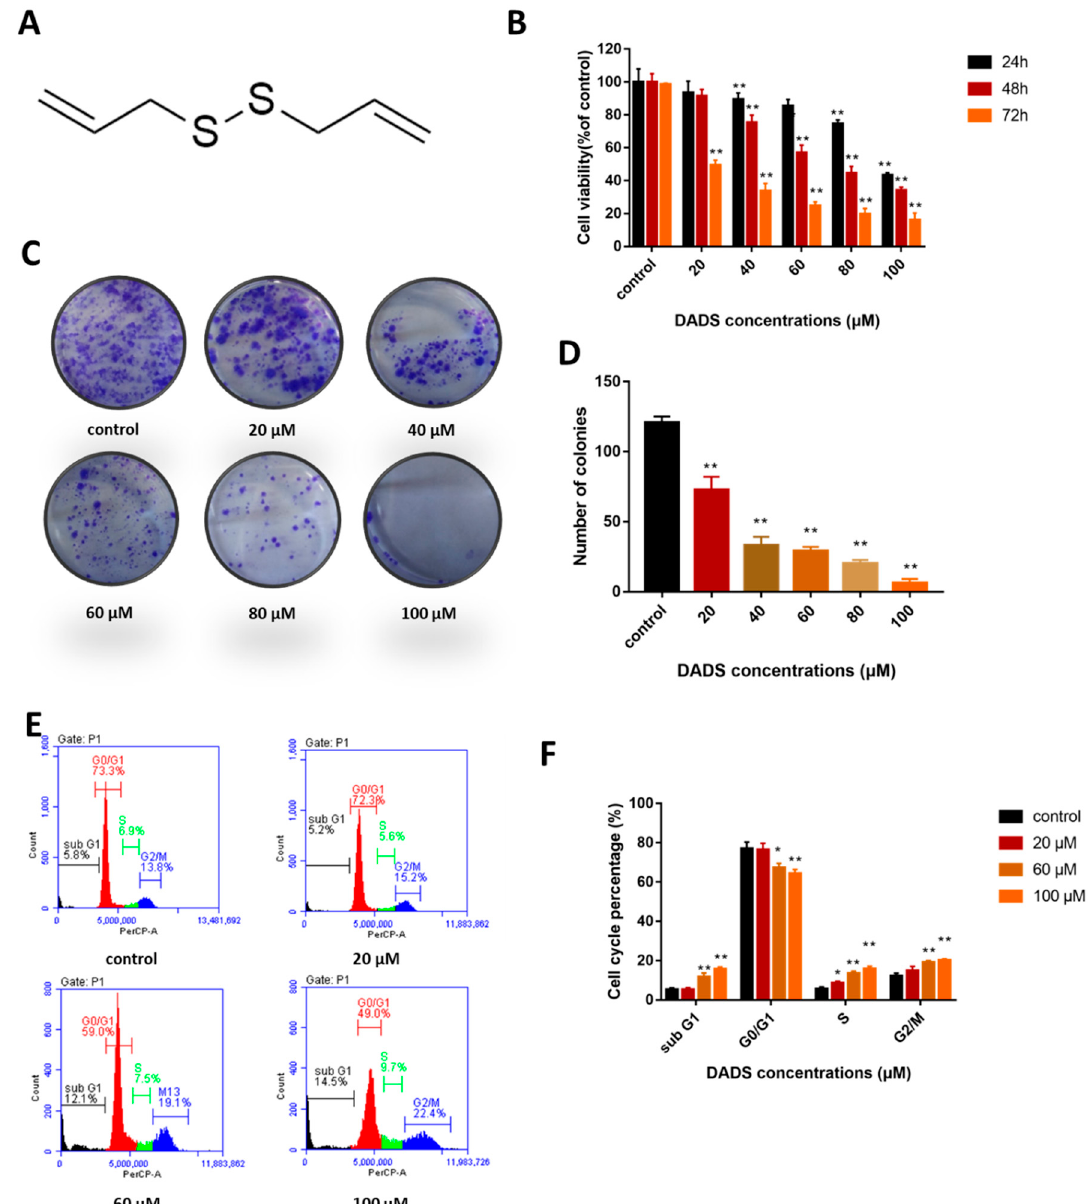
Figure 1. Inhibited cell proliferation and induces G 2 / M cell cycle arrest in osteosarcoma MG-63 cells. ( A ) Chemical structure of diallyl disulfide (DADs). ( B ) Cell viability. MG-63 cells were treated with the indicated dose of DADs (0, 20, 40, 60, 80, and 100 µ M) for di ff erent times (24, 48, and 72 h). Cell viability was detected by CCK8 assay ( n = 3 ). ( C , D ) Clone formation. MG-63 cells were treated with 0, 20, 60, and 100 µ M DADs, and the number of cell colonies was measured by clone formation assay 9 days later. ( E , F ) Cells were treated with DADs for 24 h, and the cell cycle was detected by flow cytometry. G 2 / M cell cycle arrest was observed in MG-63 cells. The percentage of the sub G 1 , G 0 / G 1 , S, and G 2 / M phase cell populations were represented by the mean ± SD of at least three independent experiments. Statistical di ff erences were analyzed by student’s t-test ( * p < 0.05, ** p < 0.01 compared with control group).